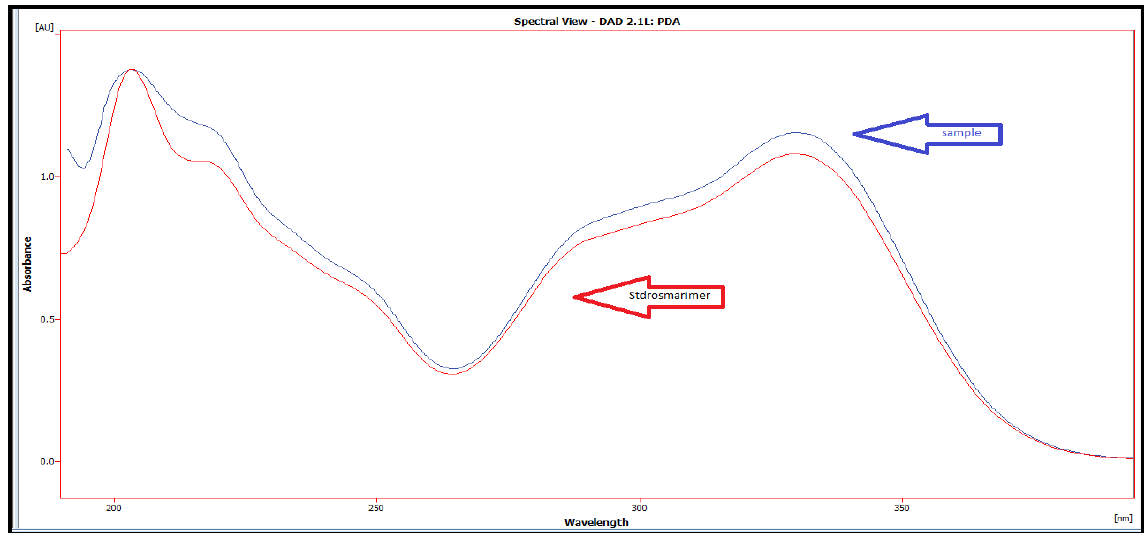
Figure 15. The UV spectrum of isolated compound number1 and Rosmarinic acide standard.